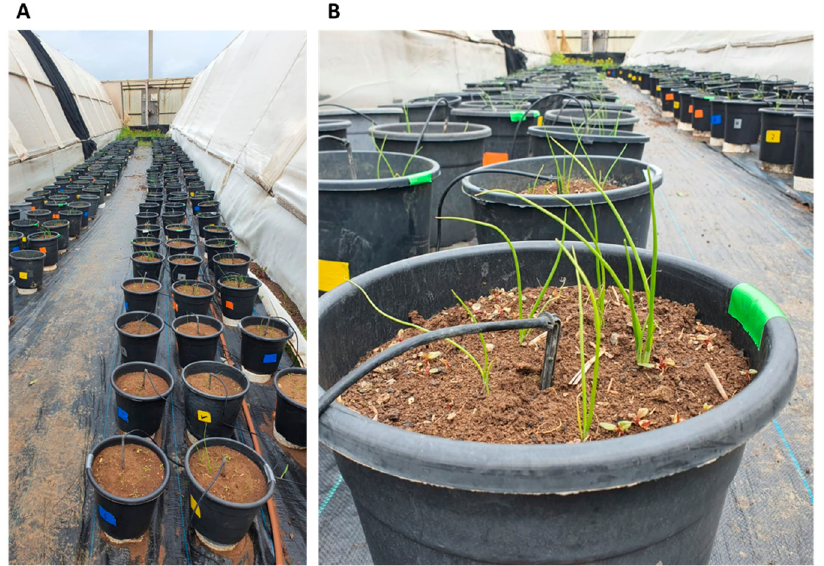
Figure 2. The semi-field pot experiment setting ( A ) and the 3rd-day aboveground sprouting ( B ). Two onion varieties were tested in a pot trial under field conditions at the Avnei Eitan Experimental Farm in the Golan Heights (north-eastern Israel): white Orlando cv. ( A , left side pots) and red Noam cv. ( A , right side pots). The pots were infected separately with each pathogen, F. oxysporum f. sp. cepae (B14) and F. acutatum (B5), and tested against a combination of the two pathogens and an unprotected control. Three pesticides were inspected as protective treatments: Prochloraz (Pr), Azoxystrobin + Tebuconazole (Az-Te), and Fludioxonil + Sedaxen (Fl-Se) (Table 1). The pots in the Prochloraz and Az-Te treatments were divided into two subgroups of five pots—a high-dose (0.3%) and a low-dose (0.15%) pesticide treatment applied 16, 35, and 56 days after sowing. The Fl-Se preparation was applied by seed dressing (0.003 microliters per seed).